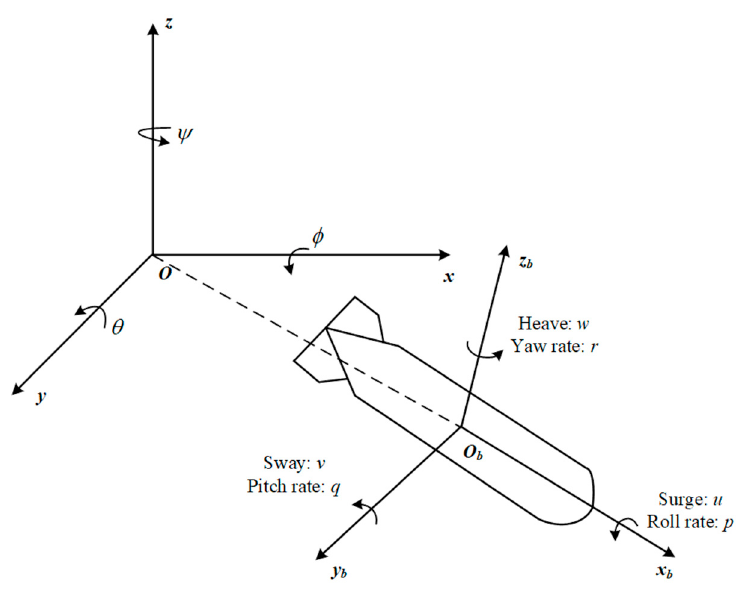
Figure 1. Coordinate systems of AUV.